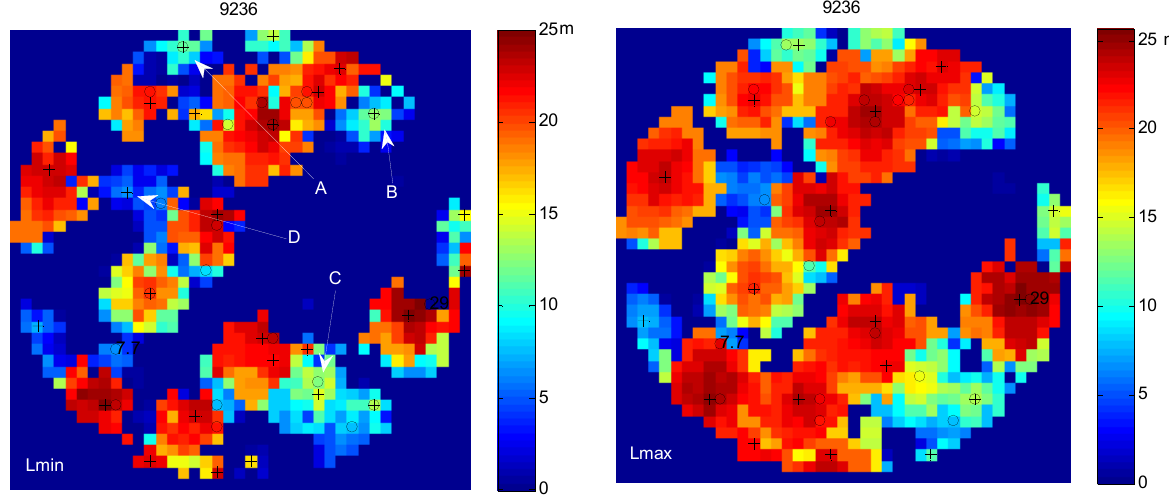
Figure 1. Four raster models for one example plot (radius 10 m) with the detected trees marked as ‘+’ and the field-measured trees marked as ‘o’. The trees designated by A, B, C and D were detectable on the Lmin image but not on the Fmax image. Lmin refers to the minimum of last returns, Lmax to the maximum of last returns, Lmean to the mean of last returns and Fmax to the first returns maximum. The return height is color